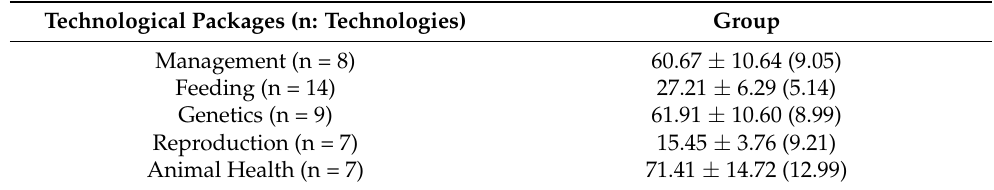
Table 2. Descriptive statistics for technological areas (Mean ± SD (CV, %) 1 ). Technological Packages (n: